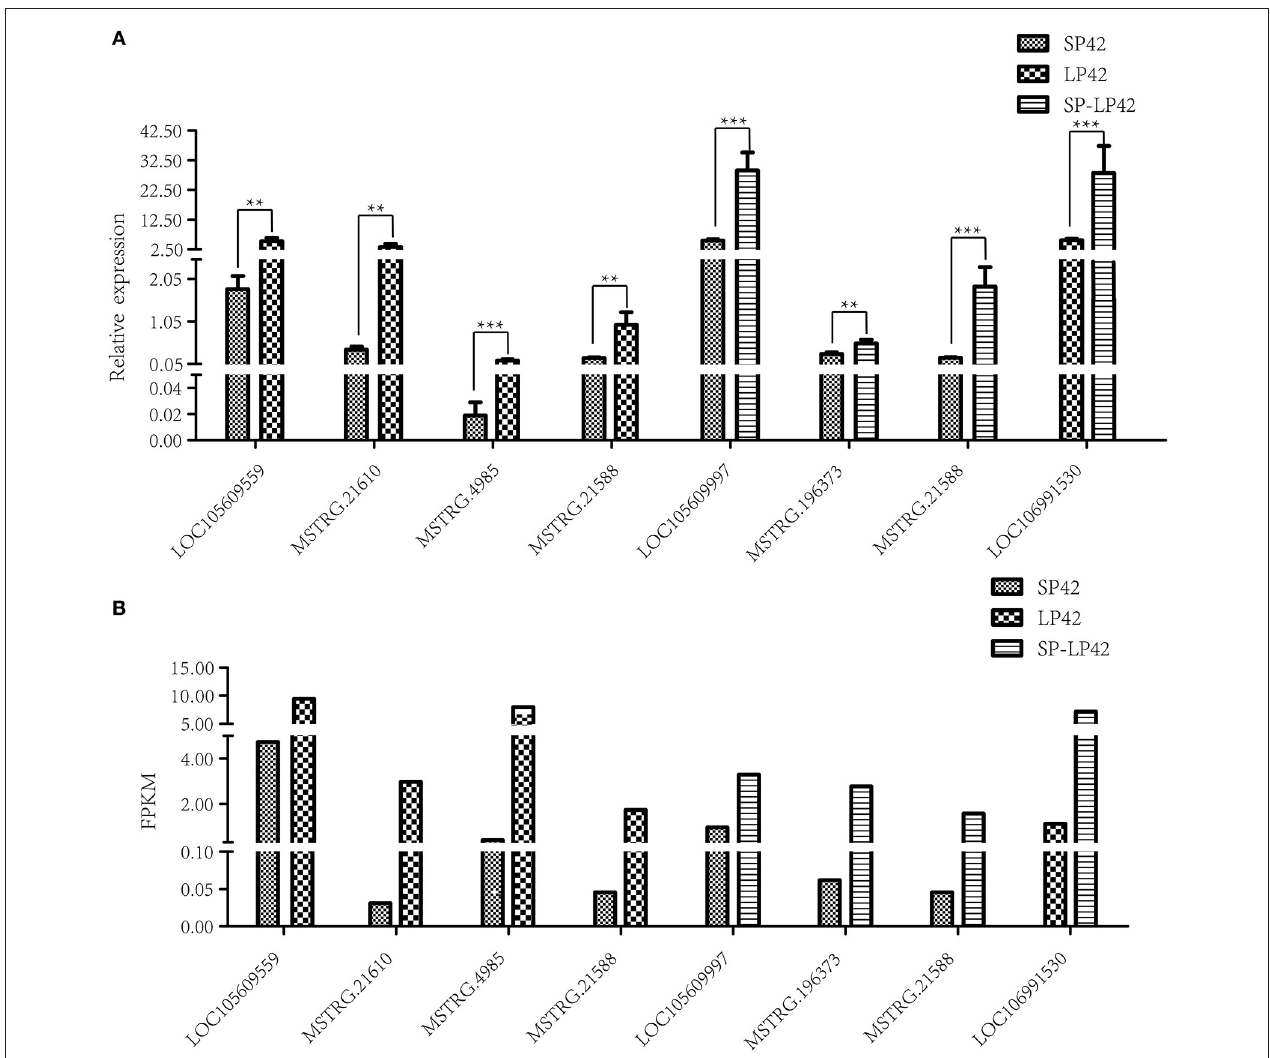
FIGURE 4 | Validation of RNA-Sequencing (RNA-Seq) data using reverse transcription real-time quantitative polymerase chain reaction (RT-qPCR). Different types of rectangles represent different light period processing. The figure ** and *** represents the p value ≤ 0.05 and 0.01, respectively. (A) RT-qPCR, (B)